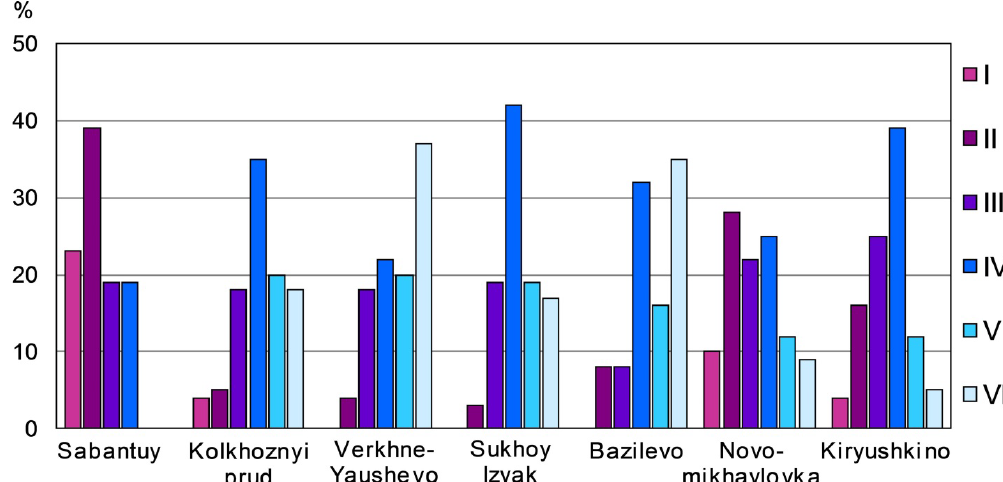
Figure 14. Histograms for morphological groups of chromian spinels from chromite paleoplacers in the Southern Pre-Urals. As shown above, the studied detrital chromian spinels vary in Mg# and Cr#, but most analyses (>70%) belong to the moderate range of Mg# = 0.3–0.6 and Cr# = 0.6–0.8. On the Mg#–Cr# diagram, most of the points correspond to the trend of negative correlation between Mg# and Cr# and fall on the field of fore-arc peridotites (Figure 15a). The TiO 2 – Cr# diagram shows that there is no significant correlation between TiO 2 and Cr#, and many points are displaced from the fields of fore-arc peridotites and abyssal peridotites (Figure 15c). In the Al 2 O 3 –TiO 2 diagram, the bulk of analyses (~70%) falls within the field of boninitic chromian spinels. However, all these features do not contradict with the ophiolitic nature of the detrital chromian spinels, since in all indicated diagrams, their compositions completely or significantly overlap with the compositions of chromian spinels from peridotites, dunites and chromitites of the Kraka ophiolitic massif.